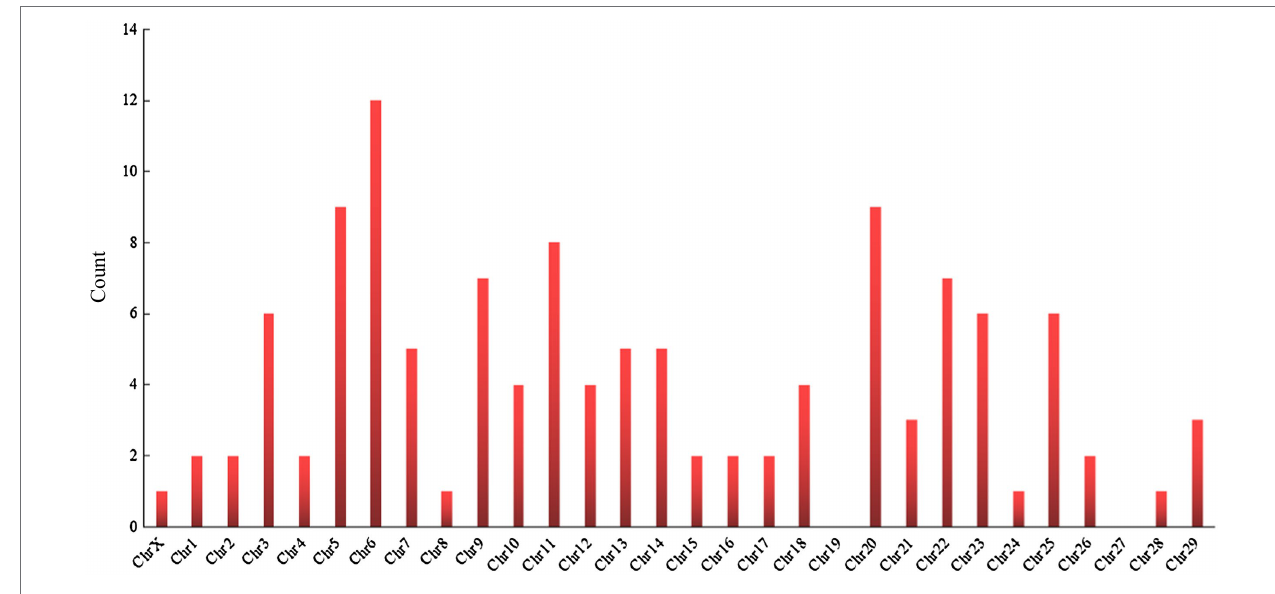
FIGURE 3 | Chromosomal distribution of genes associated with productive life.